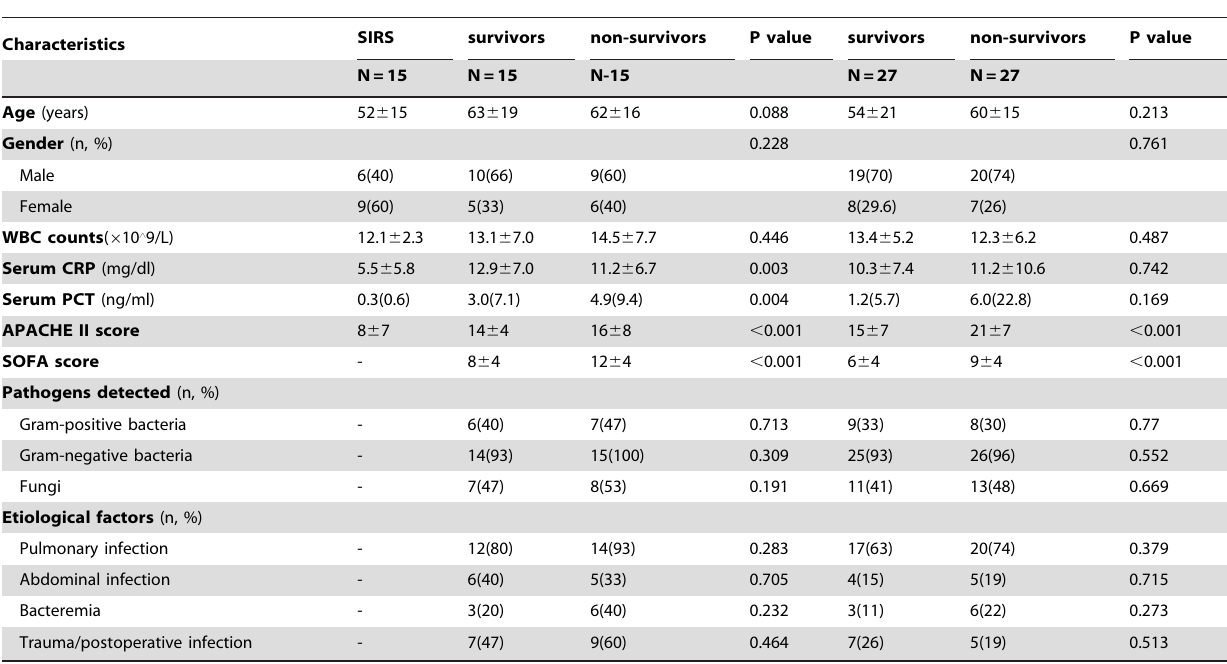
Table 1. Demographics of subjects in the discovery and verification stages.